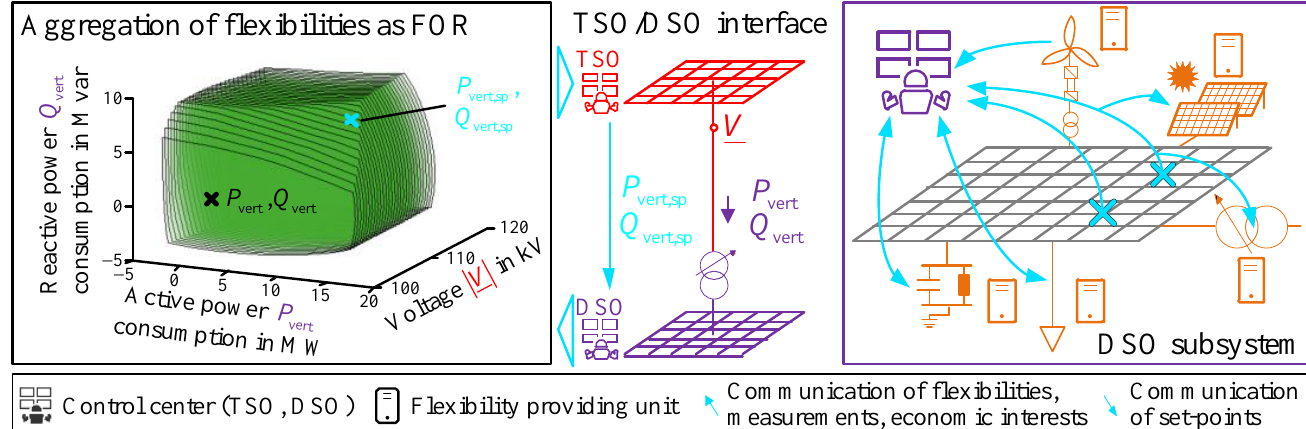
Figure 1. Aggregation of DSO flexibilities for the TSO by a FOR at the TSO/DSO